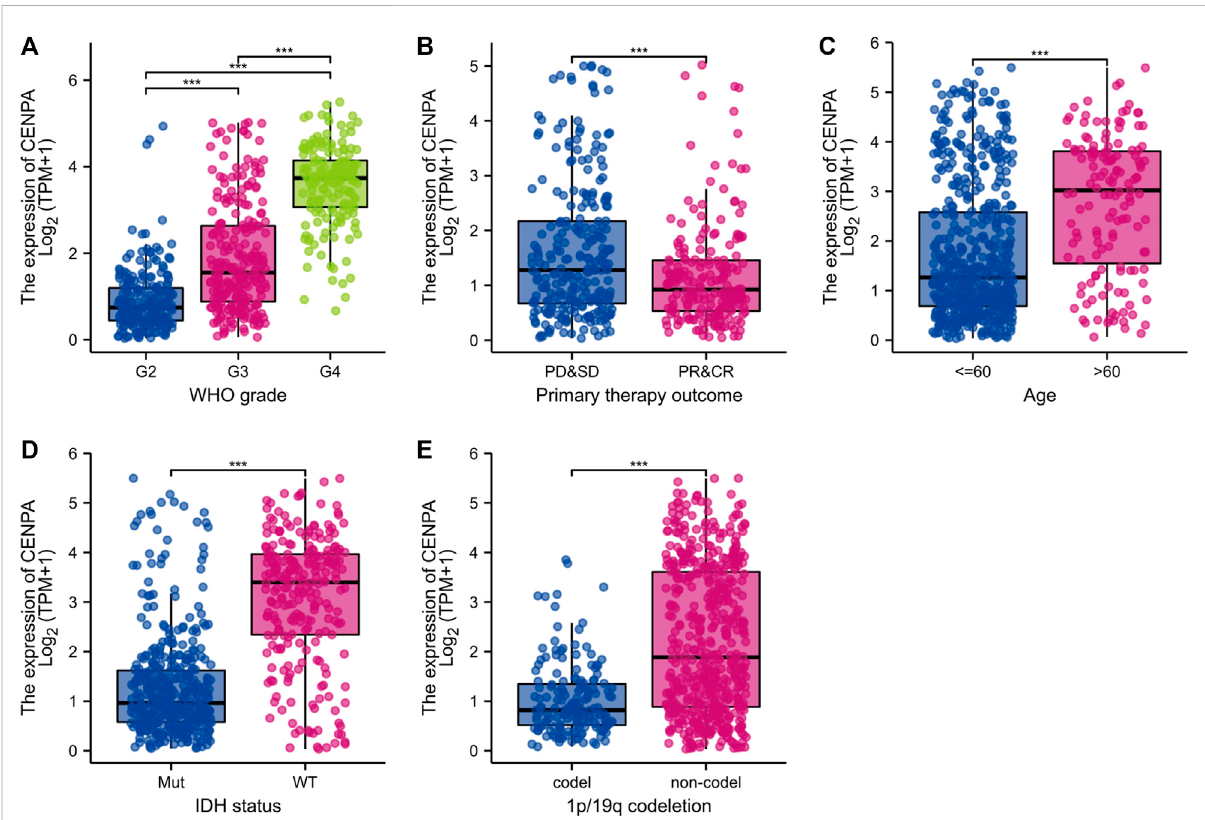
FIGURE 2 Clinical correlation analysis of CENP-A expression with clinicopathologic features. (A) WHO grade, (B) Primary therapy outcome, (C) Age, (D) IDH status, and (E) 1p/19q co-deletion. WHO, World health organization; IDH, isocitrate dehydrogenase; WT, wild type; MUT, mutated.